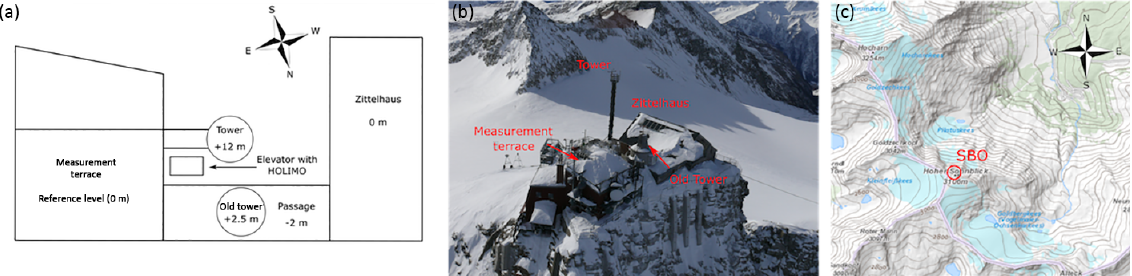
Figure 1. Sketch of the experimental setup and the surrounding structures (a) with their heights relative to the bottom of the measurement terrace. Aerial image of the Sonnblick Observatory ( b , courtesy of Michael Staudinger, ZAMG) and a topographic map of the Hohen Tauern region surrounding the Sonnblick Observatory ( c , https://basemap.at/, last access: 24 September 2017).